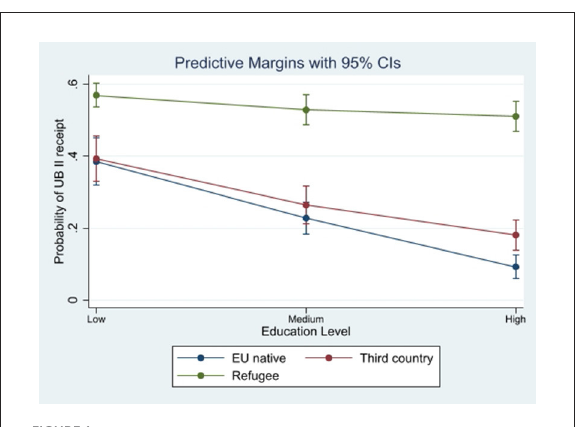
FIGURE1 Predictive marginal effects of education level on probability of UB II receipt by immigrant group. Vertical lines mark 95% confidence intervals. Source: SOEP, own